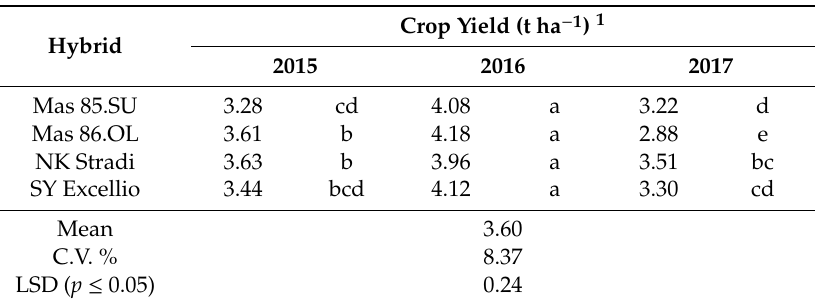
Table 2. Yield of hybrids in di ff erent